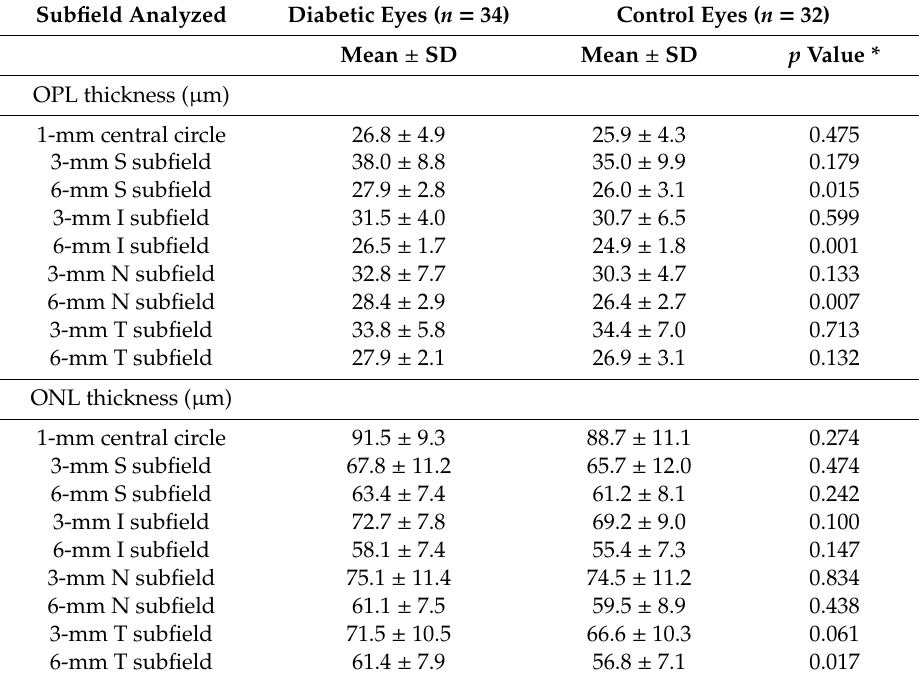
Table 3. OPL and ONL thickness analysis of diabetic eyes compared with control